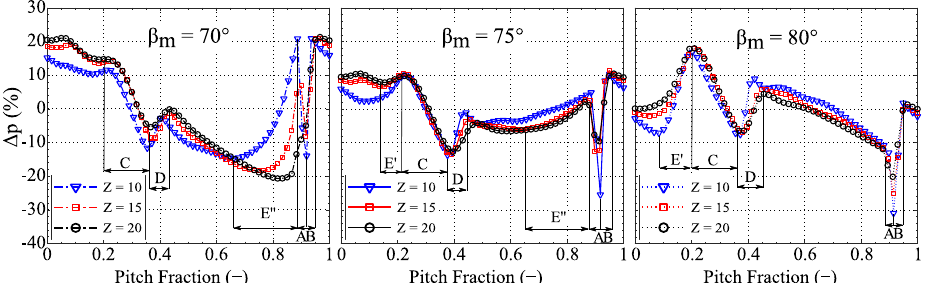
Figure 9. Mid-span pitch-wise static pressure distribution at rotor inlet radius expressed as a percent deviation with respect to mean value, grouped by outlet metal angle.